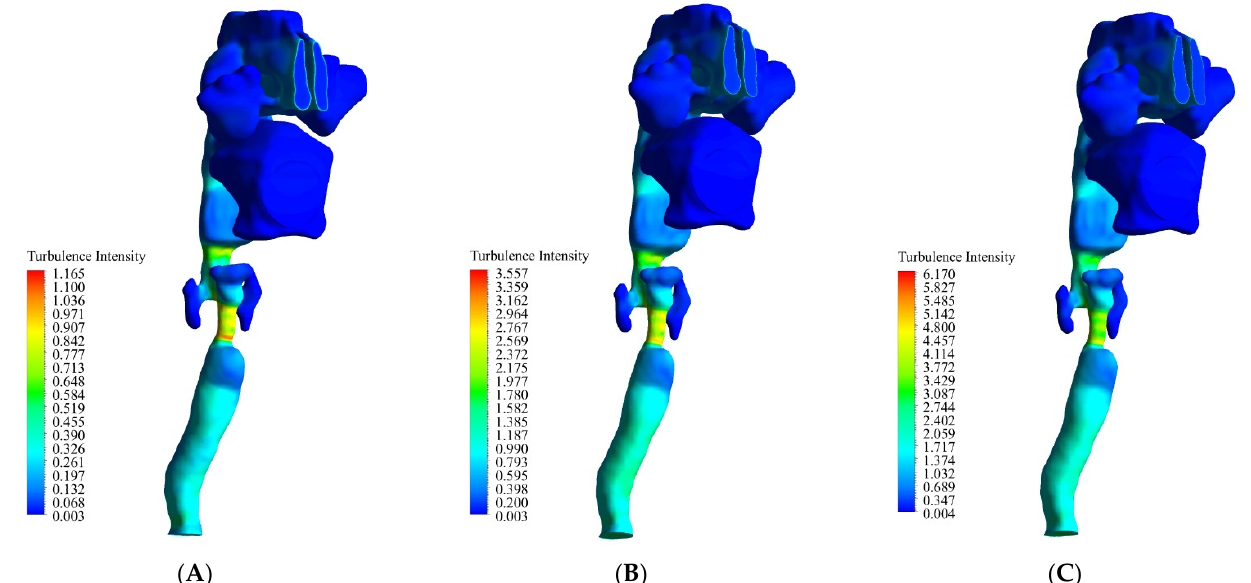
Figure 5. The turbulence intensity contours at three flow rates of 13 L/min, 55 L/min, and 100 L/min. ( A ) 13 L/min. ( B ) 55 L/min. ( C ) 100